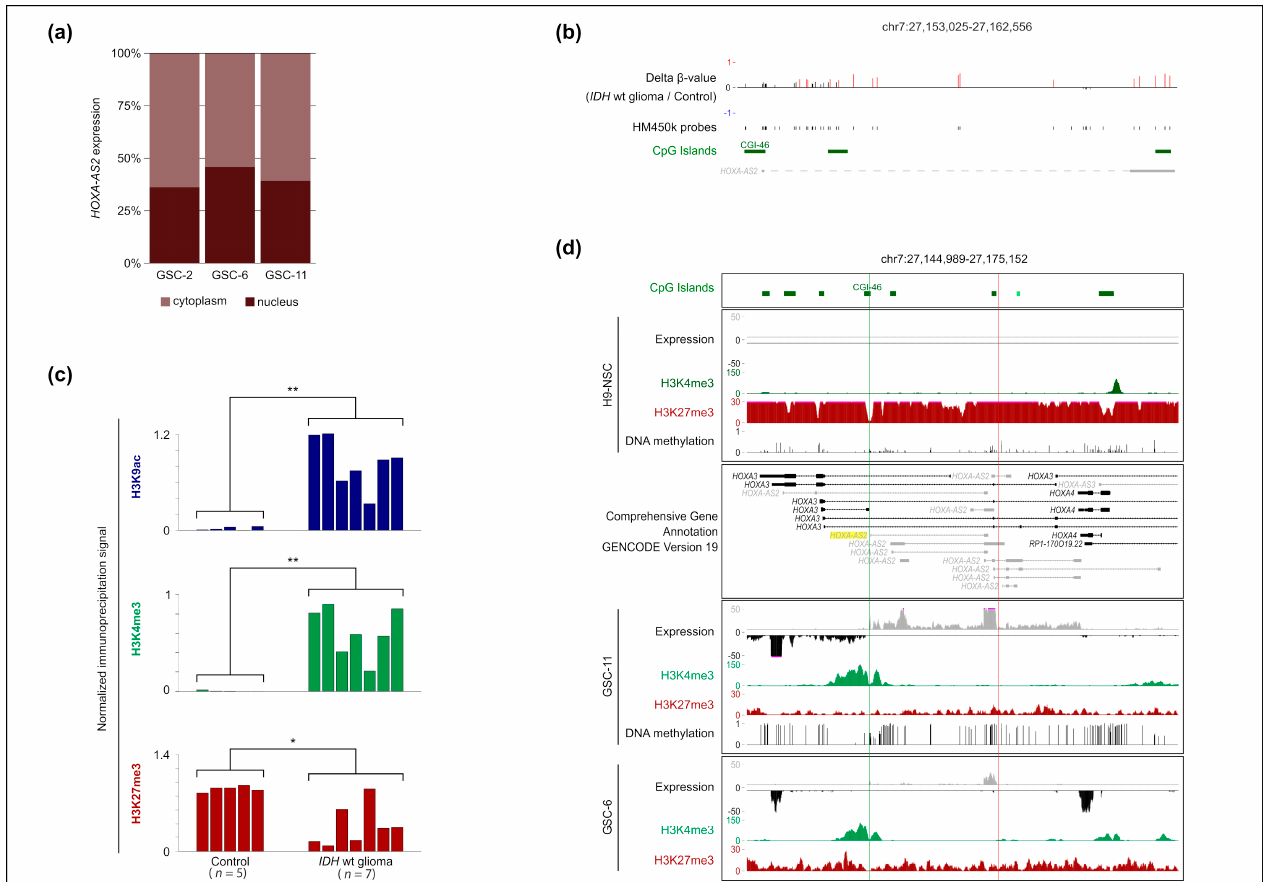
Figure 2. Subcellular distribution and molecular profile of HOXA-AS2. ( a ) Relative distribution of HOXA-AS2 transcripts in cytoplasm and nucleus of three GSC lines. Expression levels were normalized to U6 and 18S expression in the cytoplasmic and nuclear fractions, respectively. ( b ) DNA methylation changes (compared with control samples; n = 5) along the HOXA-AS2 genomic region in IDHwt ( n = 55) glioma samples, detected with the HM450K array. Significantly hypermethylated regions are in red (no hypomethylated region was observed). * p < 0.05, ** p < 0.01 (Mann-Whitney U -test). ( c ) ChIP analysis of H3K9ac, H3K4me3, and H3K27me3 at the HOXA-AS2 promoter region in control brain samples ( n = 5), and IDHmut ( n = 5) and IDHwt ( n = 7) glioma samples. The values obtained for each sample are shown. The precipitation level was normalized to that at the TBP promoter (for H3K4me3 and H3K9ac) and at the SP6 promoter (for H3K27me3). ( d ) Genome Browser integrative view at the HOXA-AS2 locus to show H3K4me3, H3K27ac, and H3K27me3 enrichment, DNA methylation (in the GSC-11 and H9-NSC lines), and the strand-oriented RNA-seq signal in GSC-6, GSC-11, and H9-NSC lines. The positions of the 5 (cid:48) and 3 (cid:48) ends identified by RACE-PCR are shown by a green and red line,